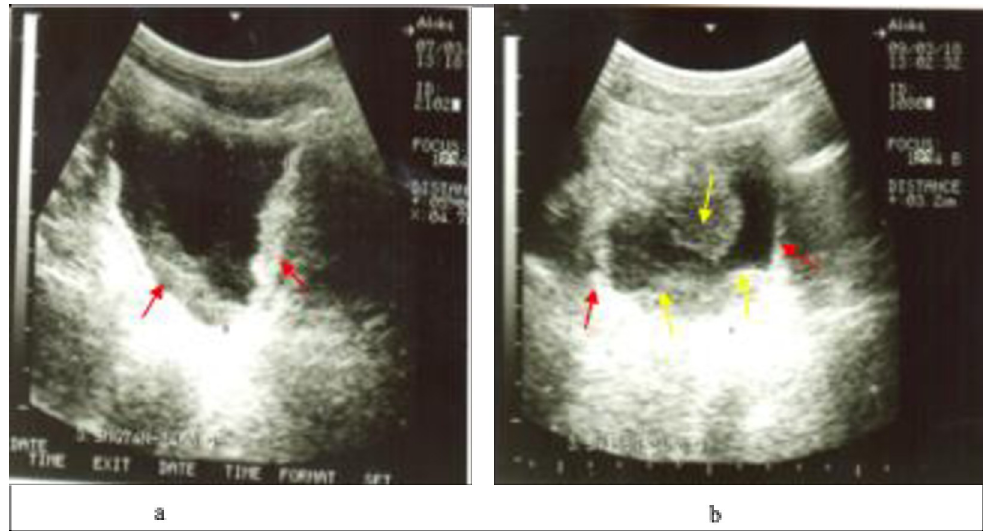
Fig 1. Urinary bladder pathology among the children; a) 10-year-old boy with diffuse thickening of the bladder wall (red arrows); b) 11-year-old boy with diffuse thickening of bladder wall (red arrows) and bladder masses (yellow arrows). https://doi.org/10.1371/journal.pgph.0001726.g001 (X 2 = 14.3969; p < 0.002). However, there was no significant difference in proportions of chil- dren with pathology in relation to age overall (X 2 = 10.2826; p = 0.113).